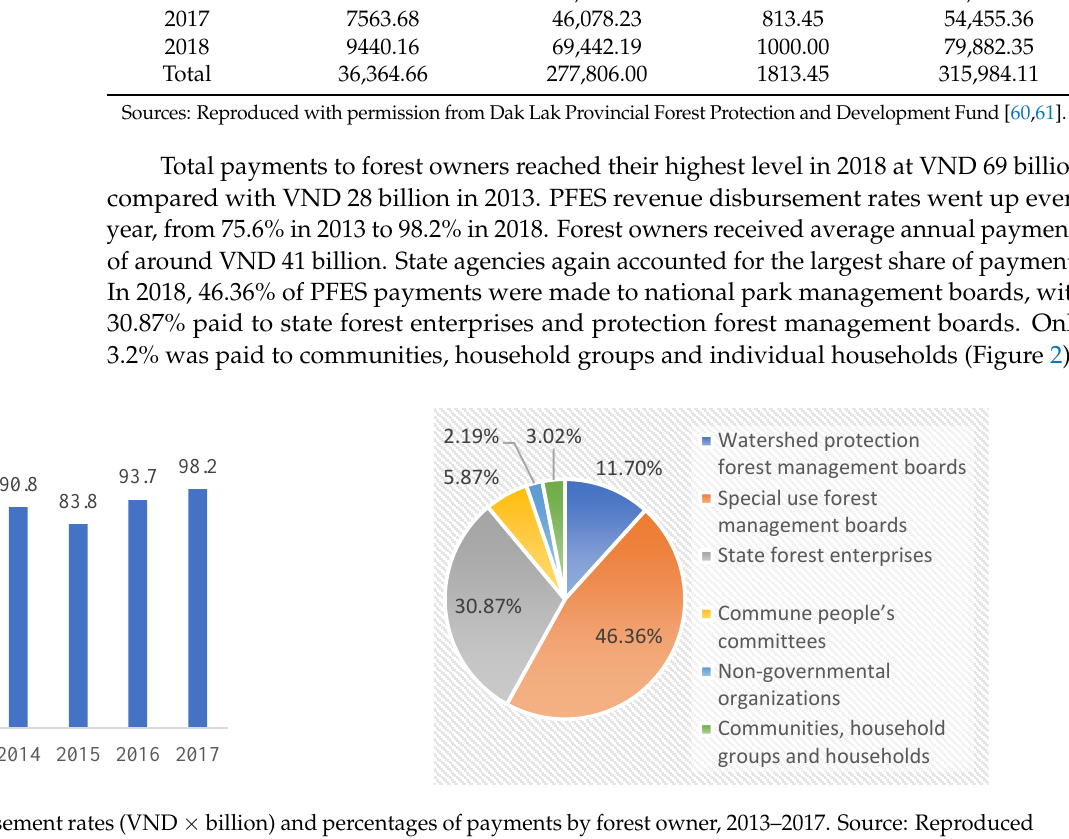
Figure 2. Disbursement rates (VND × billion) and percentages of payments by forest owner, 2013–2017. Source: Reproduced with permission from Dak Lak Provincial Forest Protection and Development Fund [60].